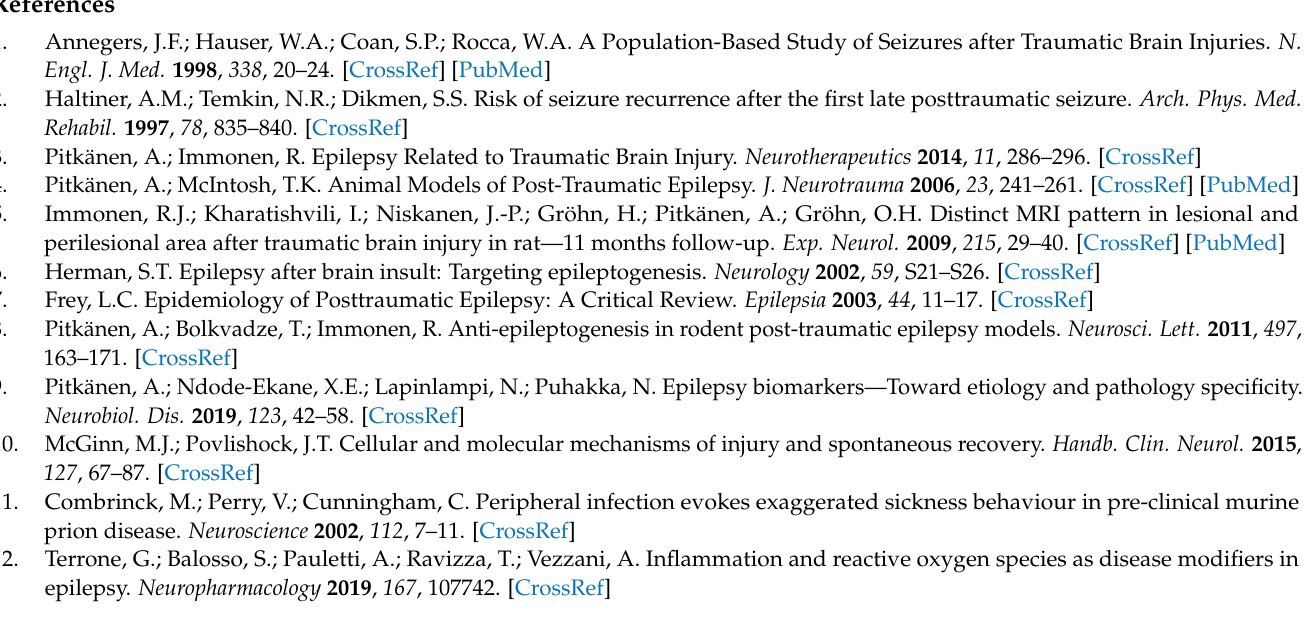
sional cortex and corresponding contralateral cortex. Figure S2: Density of c-Fos expression in layers II-IV (supragranular layers) and layers V-VI (infragranular layers) in the rostral perilesional cortex. Figure S3: Representative higher magnification photomicrographs showing c-Fos immunochemistry and Nissl staining in the rostromedial contralateral cortex. Figure S4: Representative high magnifi- cation photomicrographs showing c-Fos immunochemistry and Nissl staining in the caudomedial contralateral